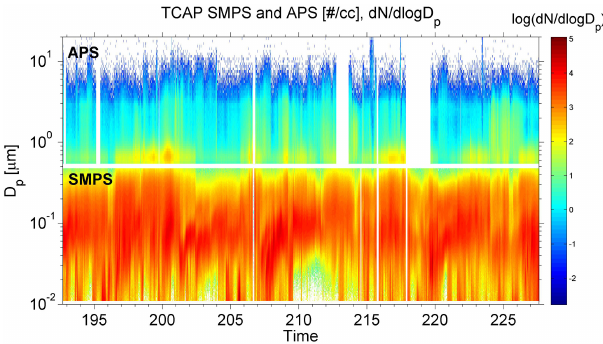
Figure 5. Time series of particle number distributions as a function of geometric diameter ( y axis) measured by in situ ground-based instruments: SMPS (bottom panel) and APS (top panel). The mea- sured SMPS and APS particle number size distributions together with optical measurements are used for retrieving the aerosol char- acteristics (Fig. 6c, d).